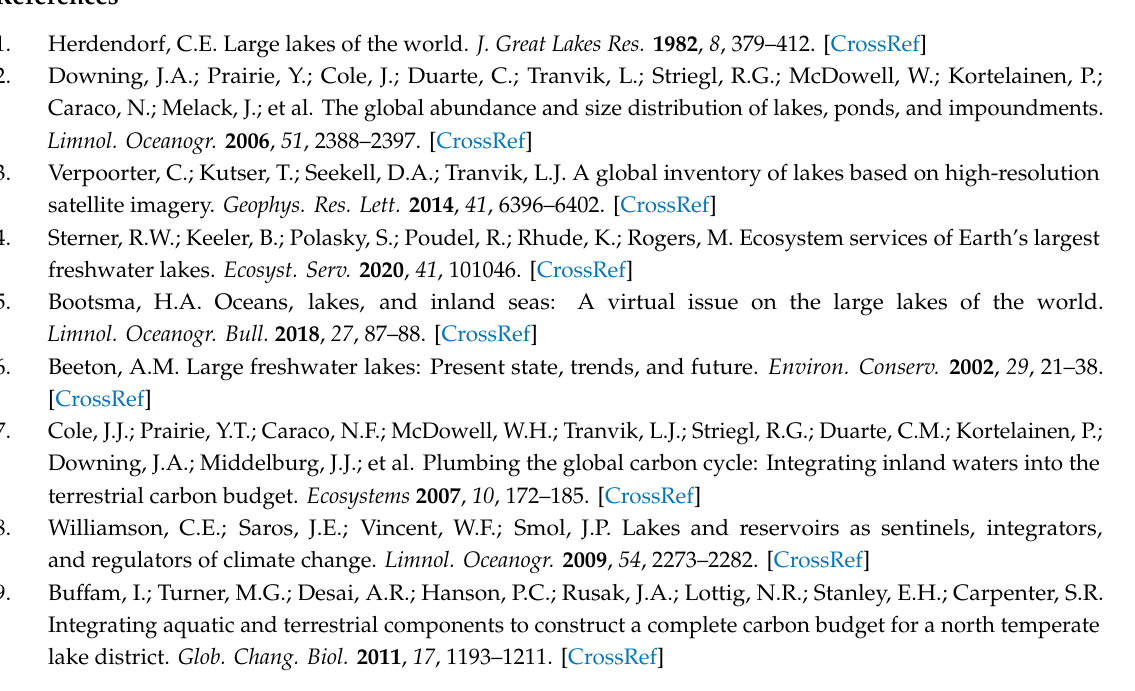
Table S1: Annual lake-wide production (mgC / m 2 / year) for each of the 11 large lakes from